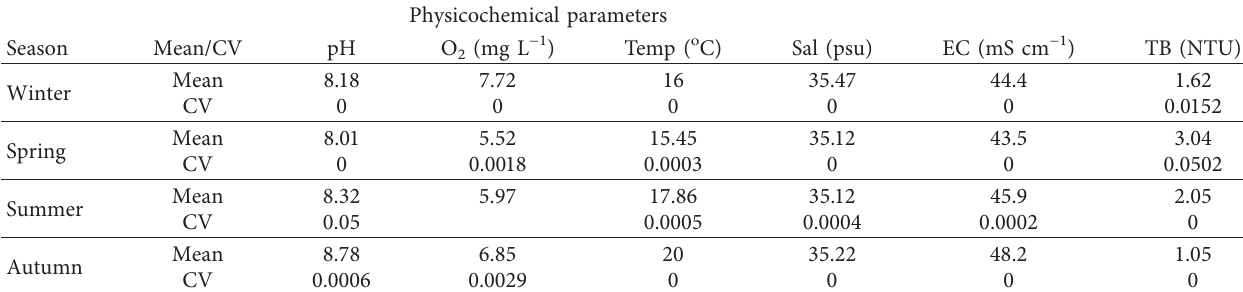
Table 1: Physicochemical parameters of Phillips Reef in Algoa